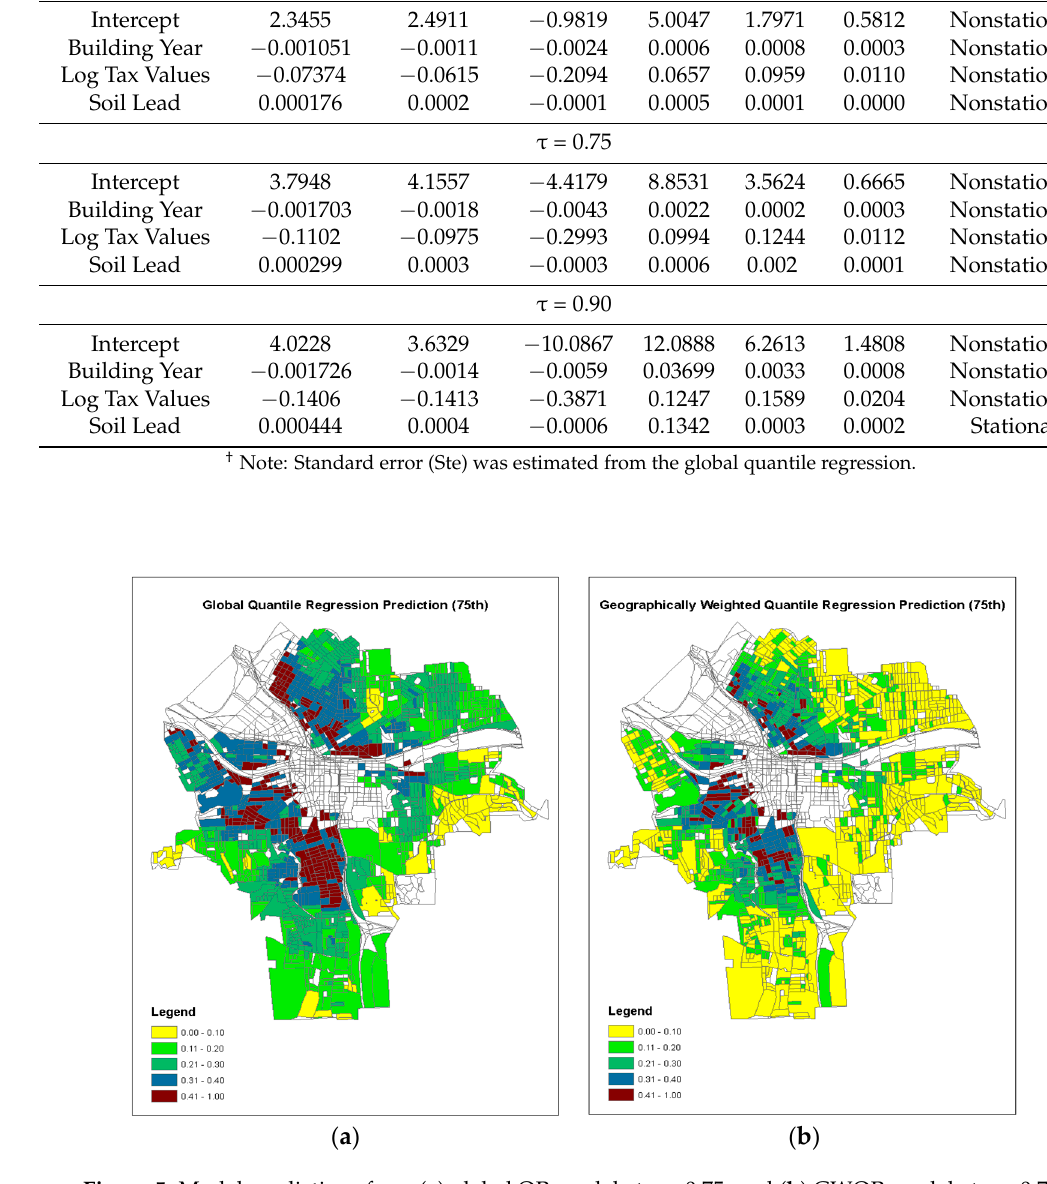
Figure 5. Model predictions from ( a ) global QR model at τ = 0.75; and ( b ) GWQR model at τ = 0.75.